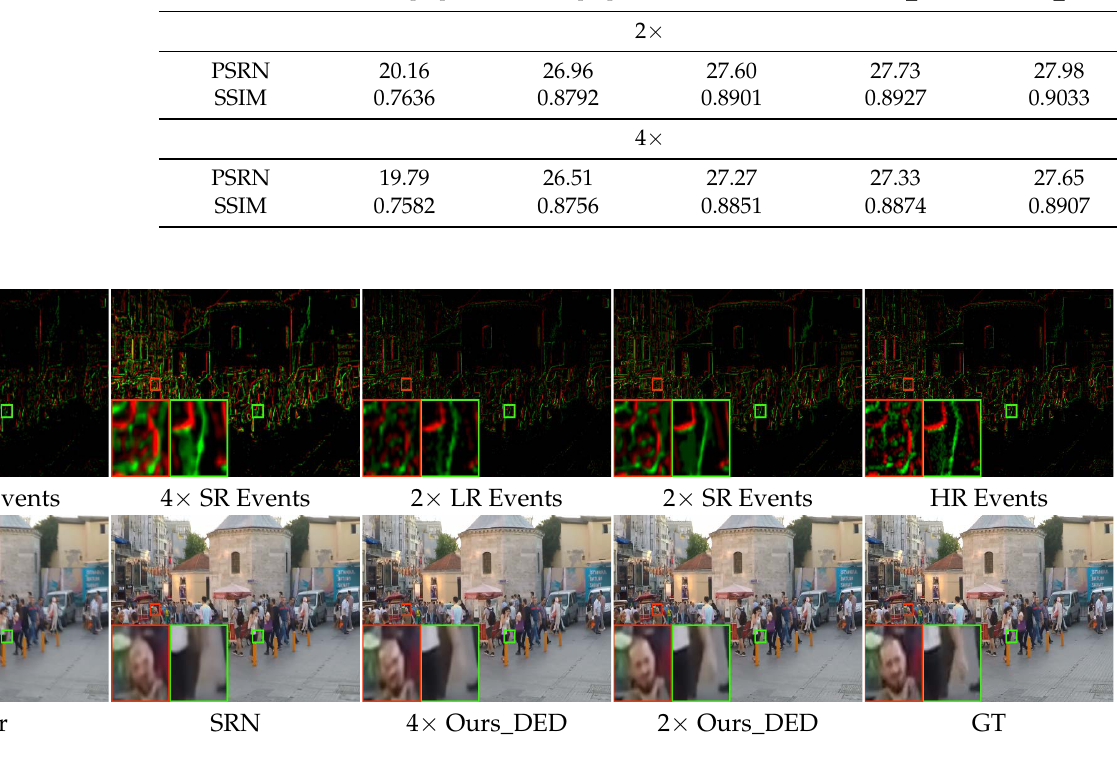
Figure 4. Visual comparisons of image deblurring without events with 2 × and 4 × events. Obviously, the results of image deblurring with events (2 × Ours_DED and 4 × Ours_DED) are better than the result without events (SRN [21]), and the 2 × spatial resolution events are better than the 4 × spatial resolution